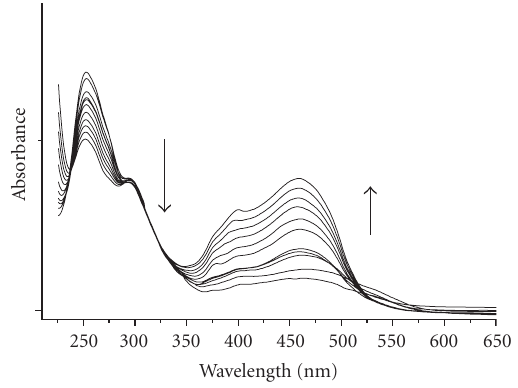
Figure 2: E ff ect of Tb 3+ concentration on the absorption spectra of SP in acetonitrile.